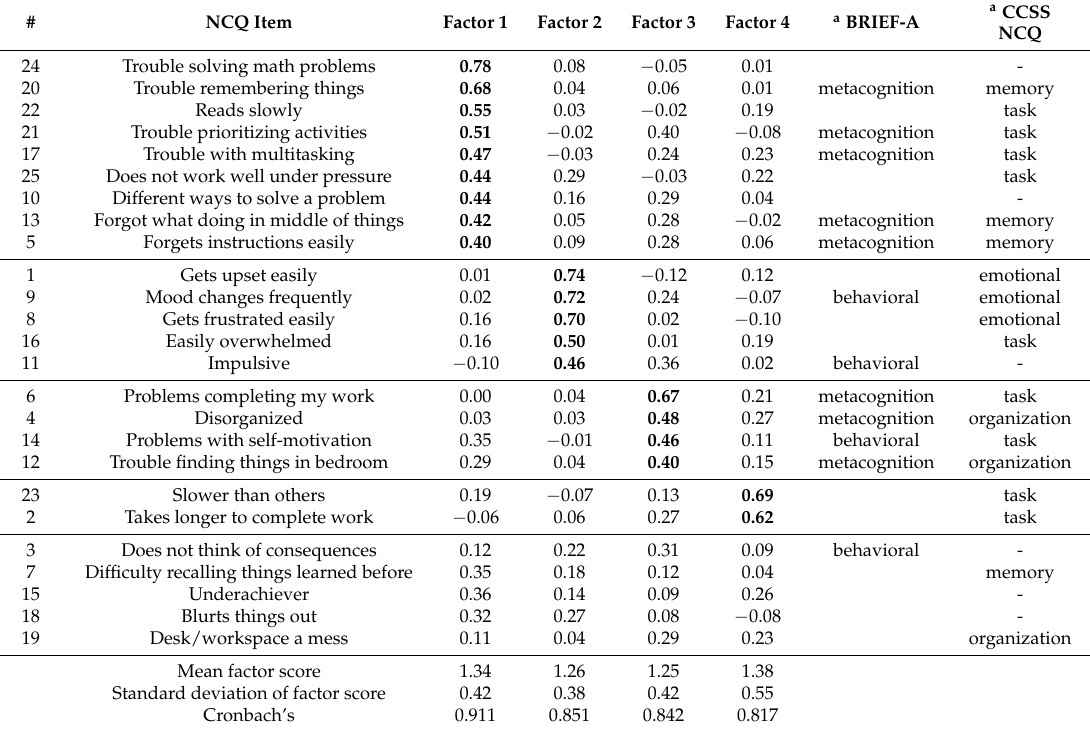
Table 1. Factor loadings, summary statistics of factor scores, and internal consistency measures ( N = 503).